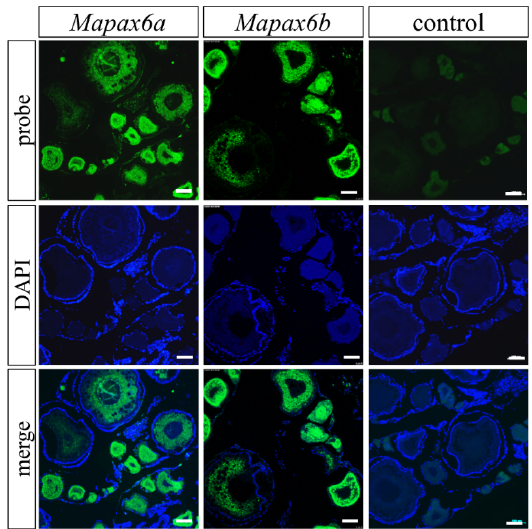
Figure 5. Distribution of Mapax6a and Mapax6b in the adult ovary. These sections were stained with nuclear dye 4 ′ ,6-Diamidino-2-phenylindole dihydrochloride (DAPI), represented by blue signals. The green fluorescent signal displays the intracellular distribution of Mapax6a and Mapax6b RNA in the ovary detected by antisense probe. The sense probe was used as a negative control. Merge micrographs of DAPI staining and probe staining are shown in the third row. Scale bars: 100 μ m.